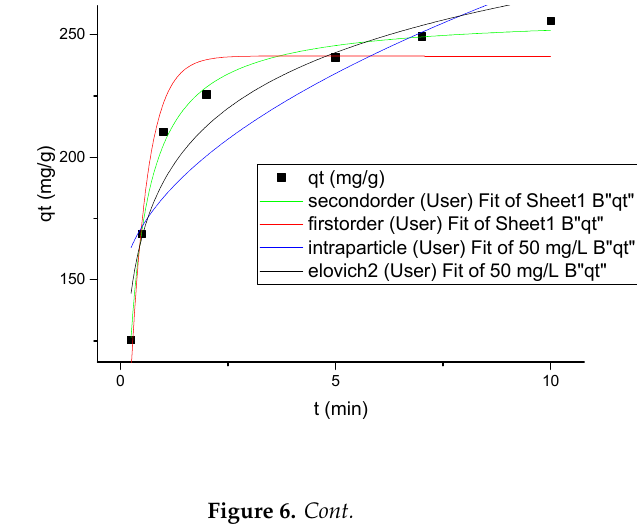
Figure 5. Nonlinear plots of isotherm models used for adsorption of CIP.